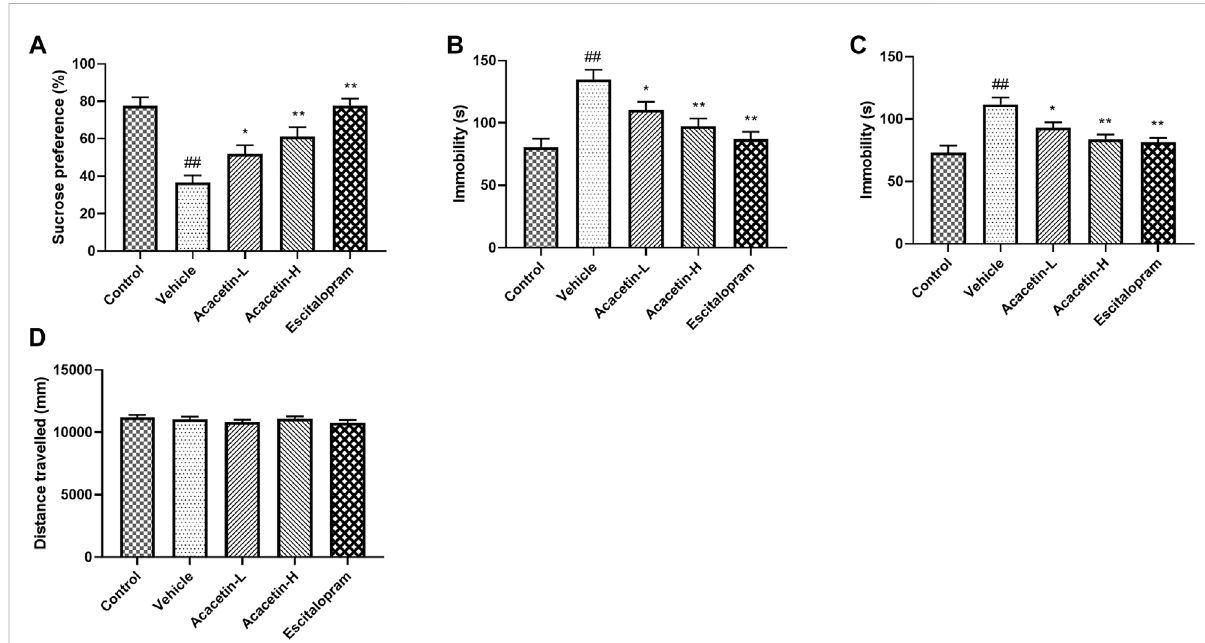
FIGURE 1 Acacetin attenuates depression-like behavior in chronic unpredictable mildstress (CUMS) mice. (A) The preference ratio ofmice in thesucrose preference test. (B) Immobility duration of mice in the tail suspension test. (C) Immobility duration of mice in the forced swim test. (D) Total distance travelled in the open fi eld test. Results are expressed as the mean ± standard error of the mean (SEM; n = 9 per group). ## p < 0.01 vs. Control; * p < 0.05, ** p < 0.01 vs.